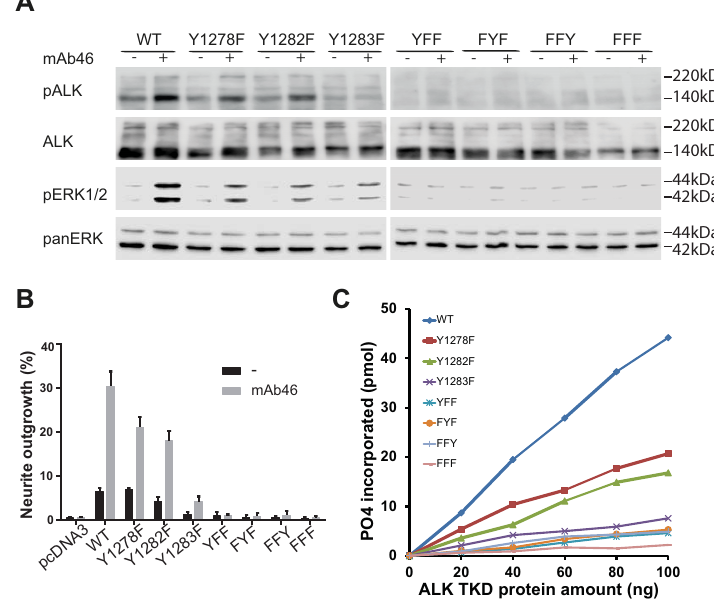
Figure 4. Analysis of the requirement of individual tyrosine residues in the YRASYY activation loop motif for full length ALK activation. ( A ) Detection of phosphorylation of ALK (Y1604) and downstream signalling activity (pERK1/2) of various ALK activation loop mutants by immunoblotting using the indicated antibodies. PanERK was employed as a loading control. Blots are representative of three independent experiments; ( B ) Neurite outgrowth assay of PC12 cells transfected with various ALK mutants, as indicated in the figure, in the presence or absence of mAb46 stimulation. Black bars represent unstimulated cells and grey bars denote cells that are stimulated with mAb46. Bars represent mean percentage ± STD of neurite-carrying cells among GFP-positive cells from three independent experiments; ( C ) In vitro kinase assay of various ALK TKDs. Substrate phosphorylation activity of the ALK TKDs mutated in various combinations of Y1278, Y1282 and Y1283 to phenylalanine was assayed employing a peptide mimic of the ALK activation loop. Increasing amounts of ALK TKD proteins were assayed at 30 ◦ C for 30